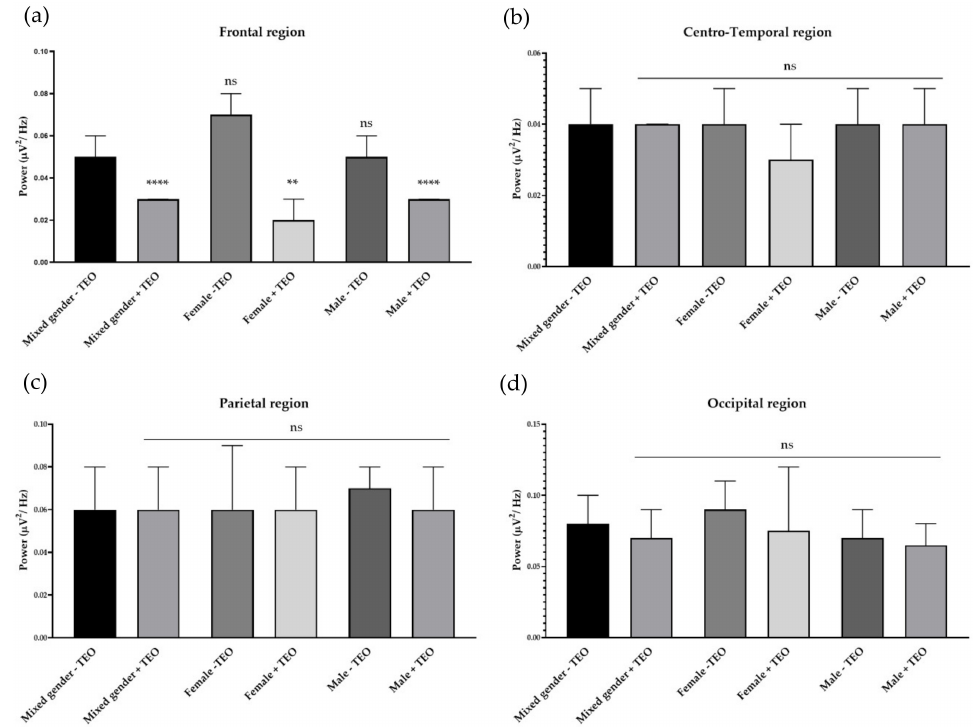
Figure 4. E ff ects of tangerine essential oil on fast alpha (12 Hz): ( a ) Frontal region; ( b ) Centro-Temporal region; ( c ) Parietal region; ( d ) Occipital region. p value: ns ≥ 0.05, ** < 0.01, **** <